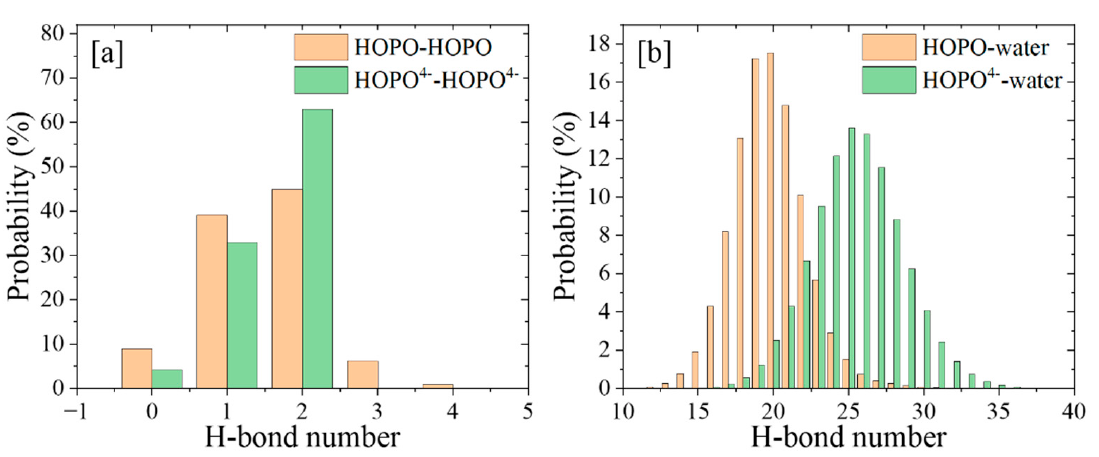
Figure 5. The count of intra- ( a ) and inter- ( b ) molecular H-bonds during the 100 ns MD simulations. Another beneficial factor for t -HOPO 4 − to maintain its favorable conformation was contributed by the Na + counterion, which was not present in the simulations of t -HOPO 0 . During the 100 ns simulation, there was always one Na + ion in the vicinity of each pair of mutually paralleled m -HOPO rings of t -HOPO 4 − (Figure 3c). These Na + ions locked the two m -HOPO rings via strong electrostatic attractive interactions to maintain the parallel conformation of t -HOPO 4 − (Figure 6 and Figure S3). The analysis of the trajectory indicated that the Na + ions may have occasionally moved away from the m -HOPO units, which was accompanied by the disruption of the parallel relationship of the two m -HOPO they locked. These wandering Na + ions did not move far away, but migrated back quickly (Figure 7), driven by the electrostatic attraction between them and the m -HOPO rings, to recover the parallel relationship between the pair of m -HOPO rings.